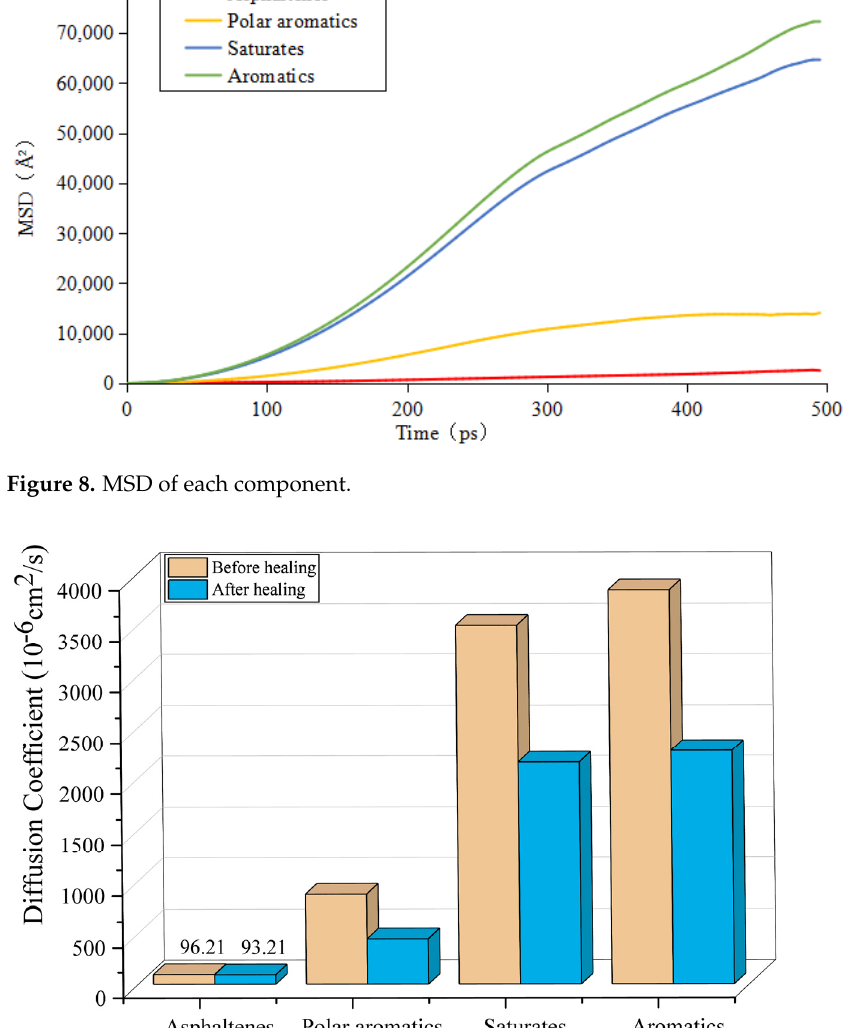
Figure 8. MSD of each component.